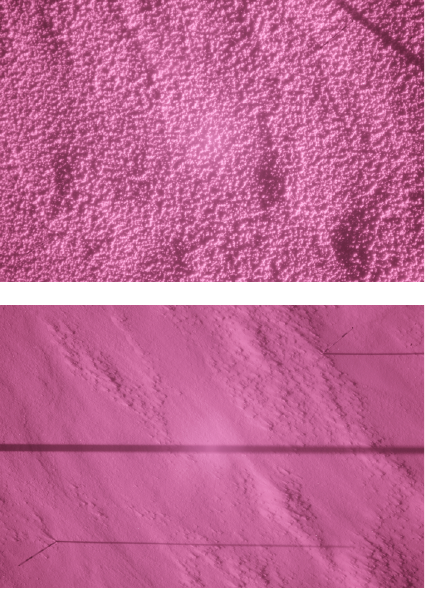
Fig. 15. Near-infrared pictures at Dome C before and after hoar disappearance caused by burying or capture of fresh snow. Event B: (a) 7, and (b) 9 February 2010.